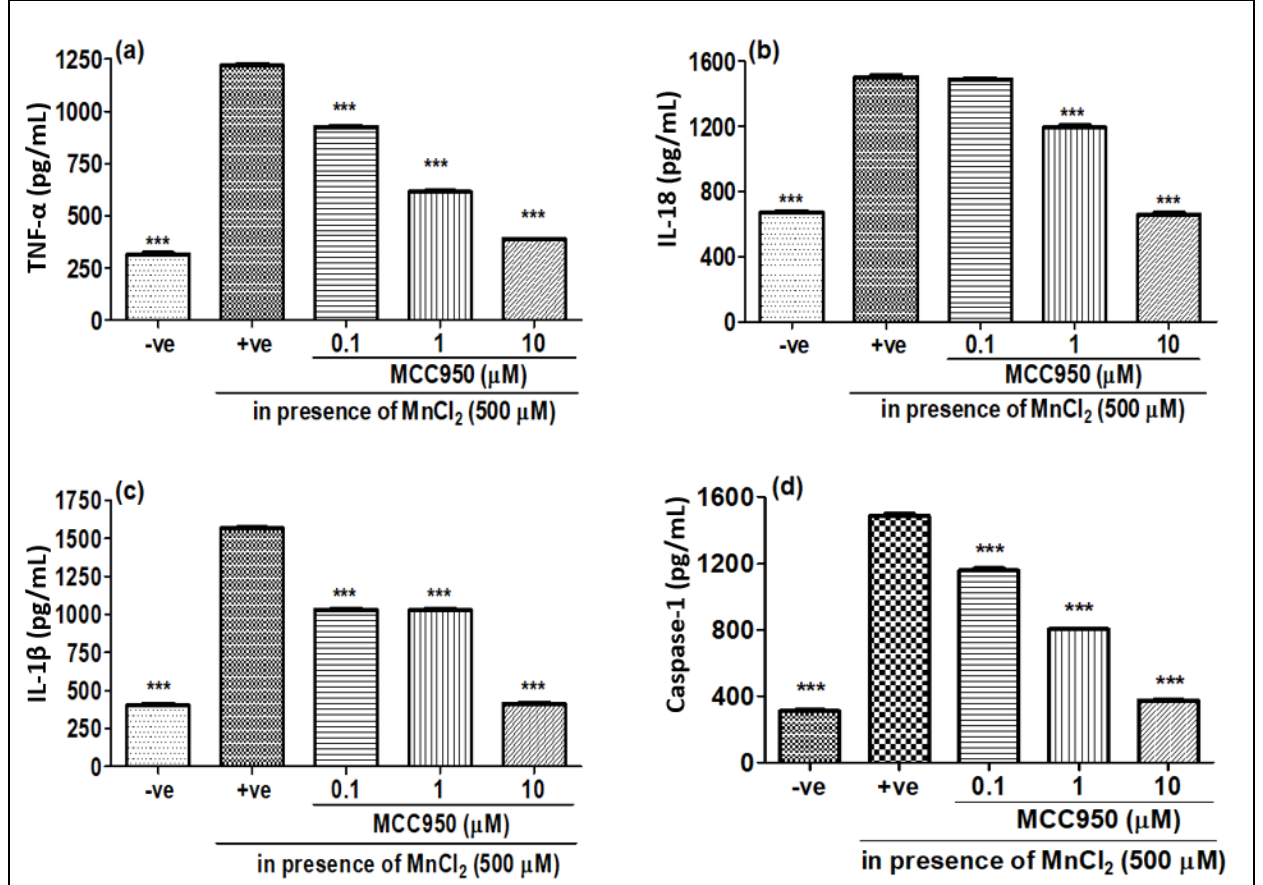
Figure 7. Effect of MCC950 on different cytokines in the presence/absence of MnCl 2 . N2a cells were exposed to MnCl 2 with/without MCC950 (0.1, 1 and 10 µM) detected by ELISA post 24 h. ( a ) TNFα , ( b ) IL-18, ( c ) IL- 1β , ( d ) caspase-1. Data represent the mean ± SD, significance calculated with reference to +ve group, i.e., MnCl 2 500 µM. *** p < 0.0001 vs. control group.